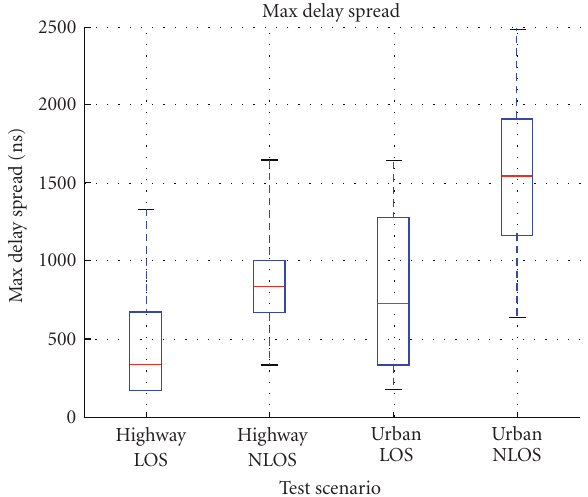
Figure 5: Comparison of coherence bandwidth for various scenar- ios. LOS, highway NLOS, and urban NLOS are presented.